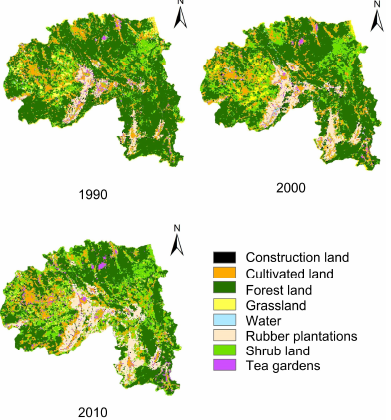
Figure 2. Land use maps and the accuracies in 1990, 2000, and 2010.